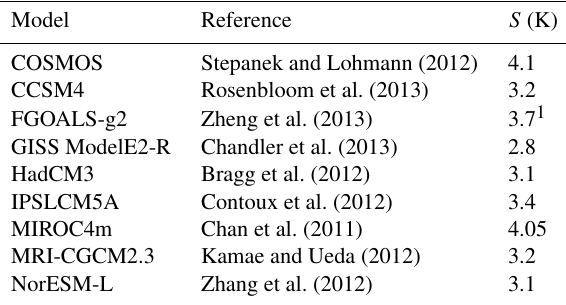
Table 1. Model data used in the